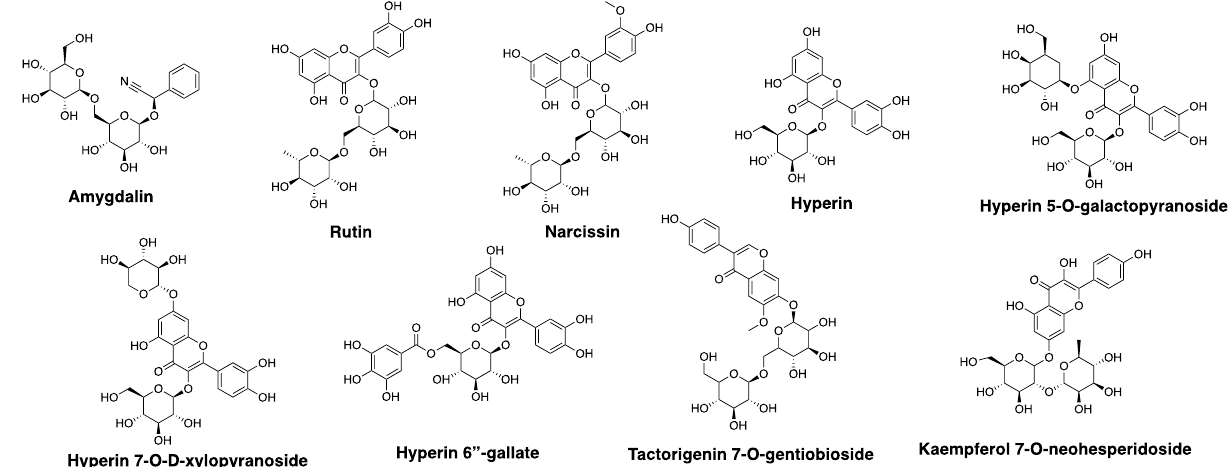
Figure 1. Two-dimensional structures of nine compounds suggested by ensemble docking to interact with multiple SARS-CoV-2 proteins and human/cat ACE2. Among them are eight flavonoids including Hyperin